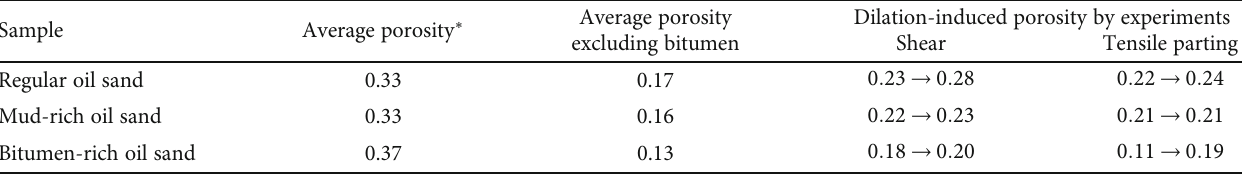
Table 1: Porosity experiments of Karamay oil sands [31].